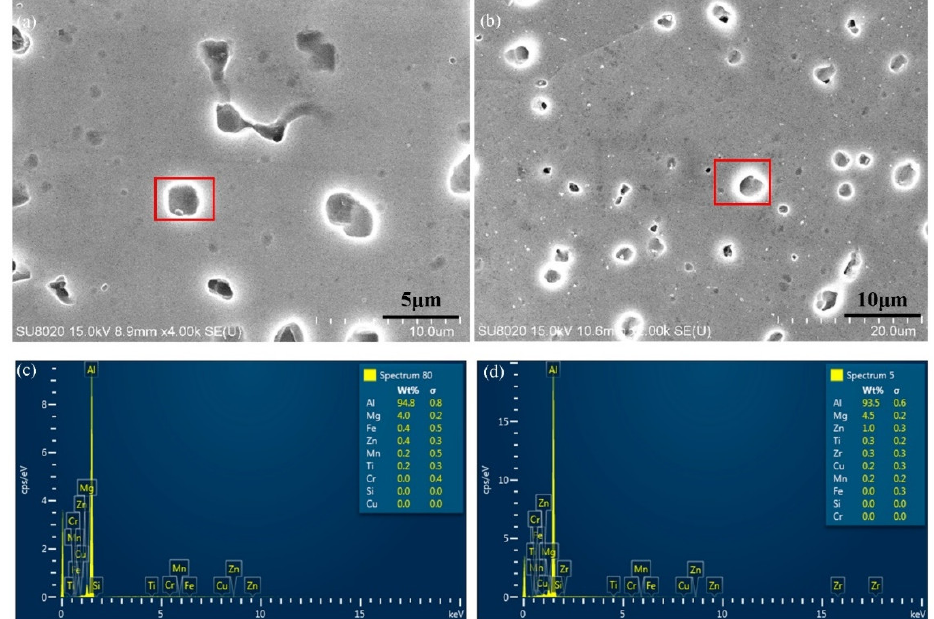
Figure 6. EDS results of the two weld zones, ( a , c ) ER5356; ( b , d ) ER5087.